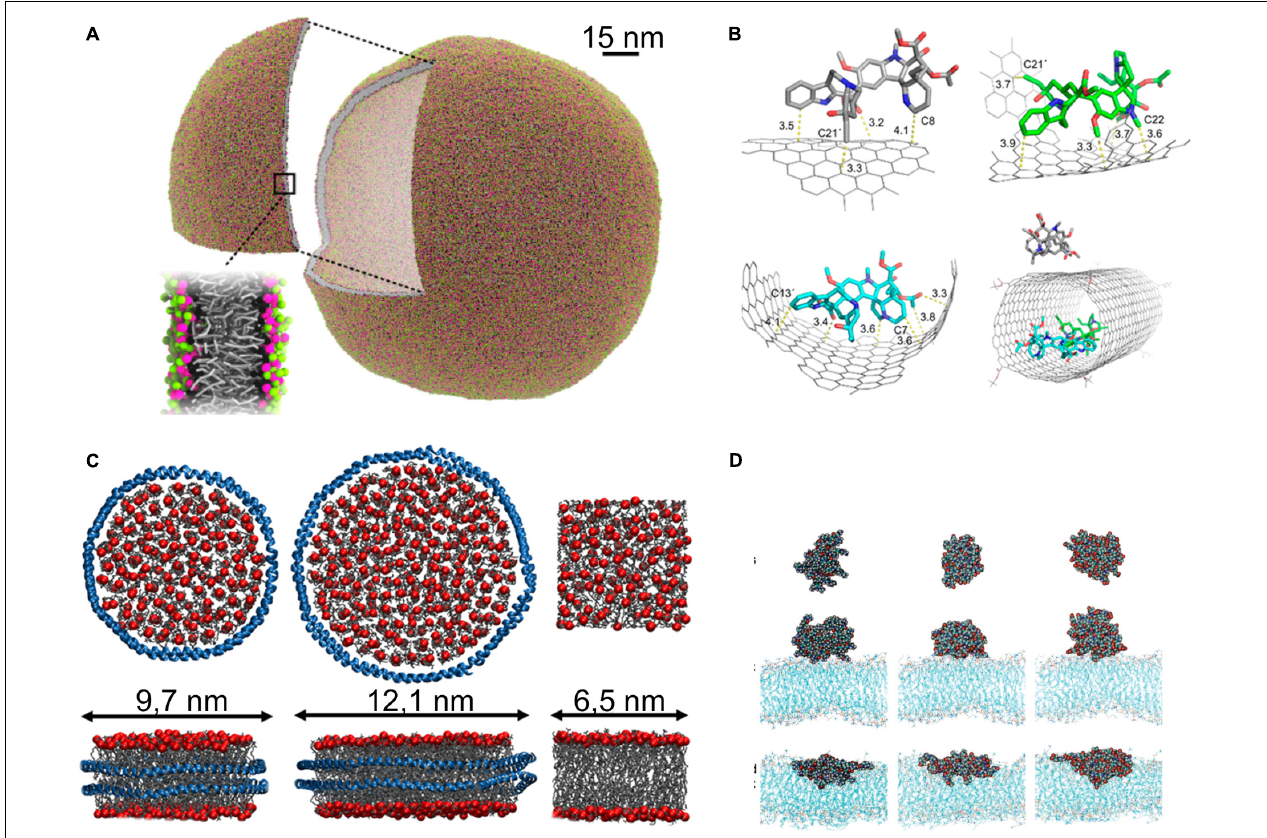
FIGURE 5 | Nanoparticles. (A) Liposome simulated with dry MARTINI model, reproduced with permission from Arnarez et al. (2015), Copyright (2015) American Chemical Society; (B) carbon nanotube used for delivery of vinblastine (Li et al., 2016a), Copyright (2016) American Chemical Society; (C) nanodiscs formed of POPC and membrane scaffold protein MSP1D1 (Left), MSP1E3D1 (middle), and lipid bilayer (right), protein is shown as blue ribbon, phosphate groups of lipids shown as red sphere, and acyl tail as gray sticks, reproduced with permission from Stepien et al. (2020); (D) PAMAM dendrimer in water phase (top), at the